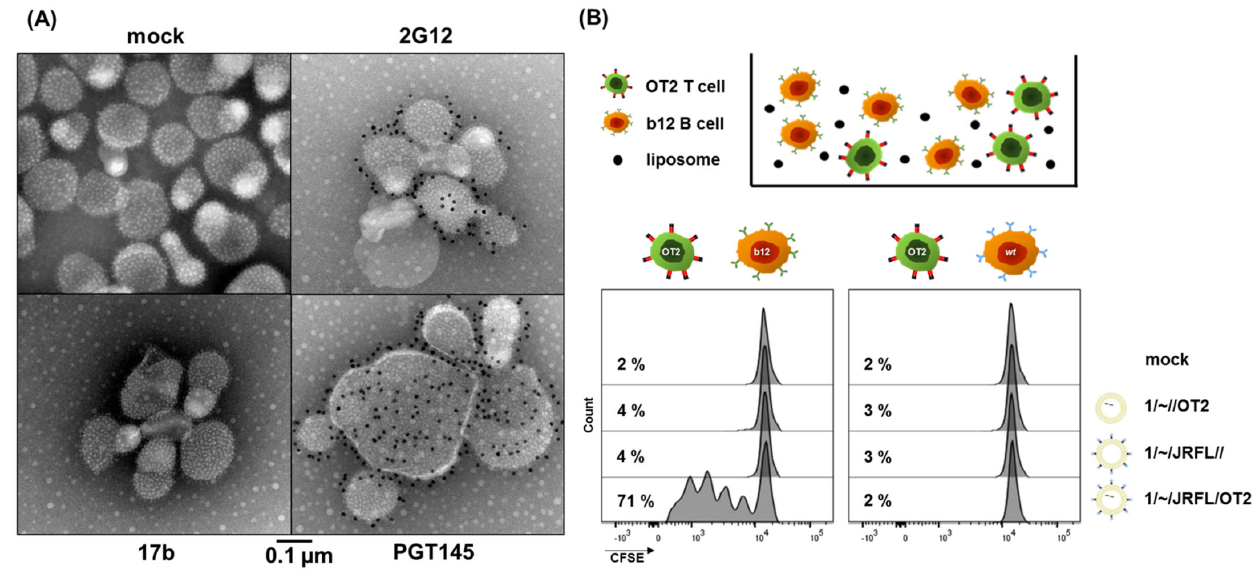
Figure 1. In vitro characterization of first ‐ generation liposomes. ( A ) Immunogold staining of T helper liposomes. The conformation of the Env trimers on the surface of first ‐ generation T helper liposomes was evaluated by negative stain TEM of liposomal samples treated with gold ‐ coupled antibodies 17b, 2G12 and PGT145. The unstained liposomes appear as spherical particles with a dense array of Env trimers on the surface (upper left). Black dots on the EM images indicate bind ‐ ing of the respective antibodies to liposome ‐ coupled Env. ( B ) In vitro intrastructural help. Co ‐ cultures of 1 × 10 5 b12 or wild ‐ type (wt) B cells and 1 × 10 5 CFSE ‐ labeled OT2 T cells were in ‐ cubated in the presence of different 1 ‐ Gen liposomal formulations (2 μ g/mL bulk Env). After 72 h, T cell proliferation was analyzed by flow cytometry based on the CFSE